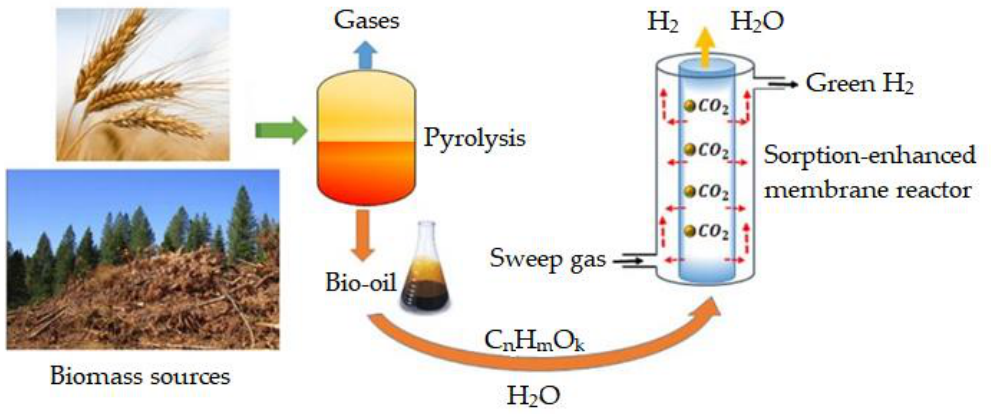
Figure 3. Hydrogen production scheme via steam reforming of bio-oil [55].